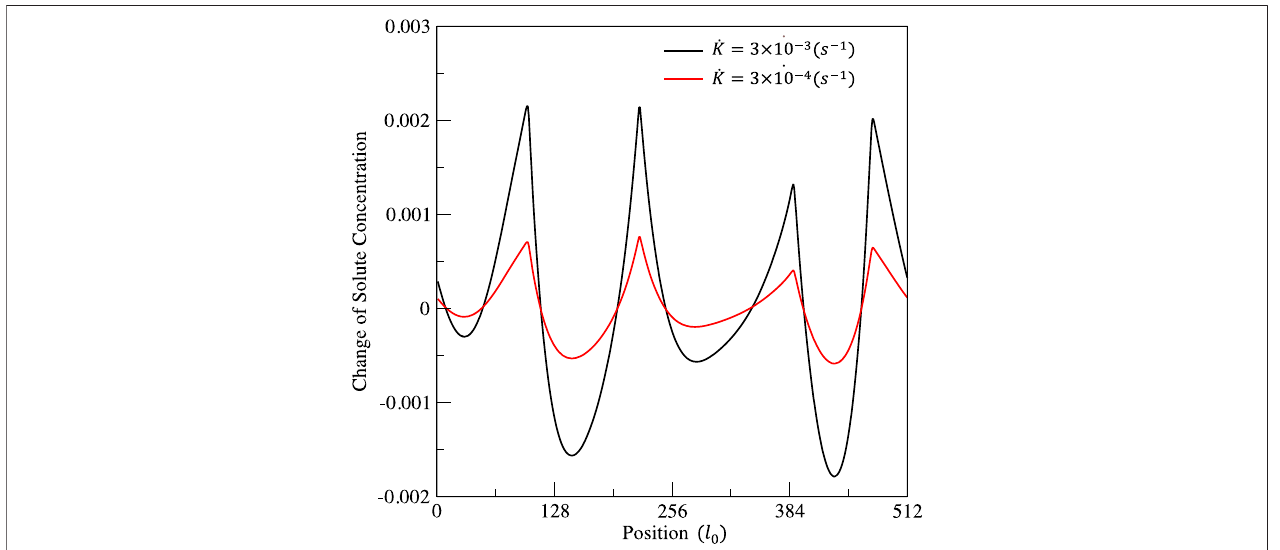
FIGURE10| Distributionofthesoluteconcentrationchange Δ c A attimet (cid:2) 1816s.Simulationcell:512 l 0 × l 0 × l 0 ;dparate:3 . 0 × 10 − 3 ;sinkstrength z d , GB (cid:2) 0 . 005; the rest model parameters are the same as that of the Model 1 described in Section 4.4 .